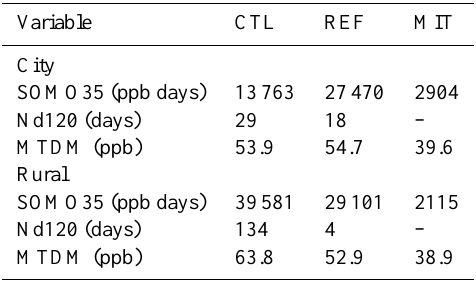
Table 5. Ozone exposure indicators for the control simulation and the relative differences between the latter and the two future projec- tions for the city of